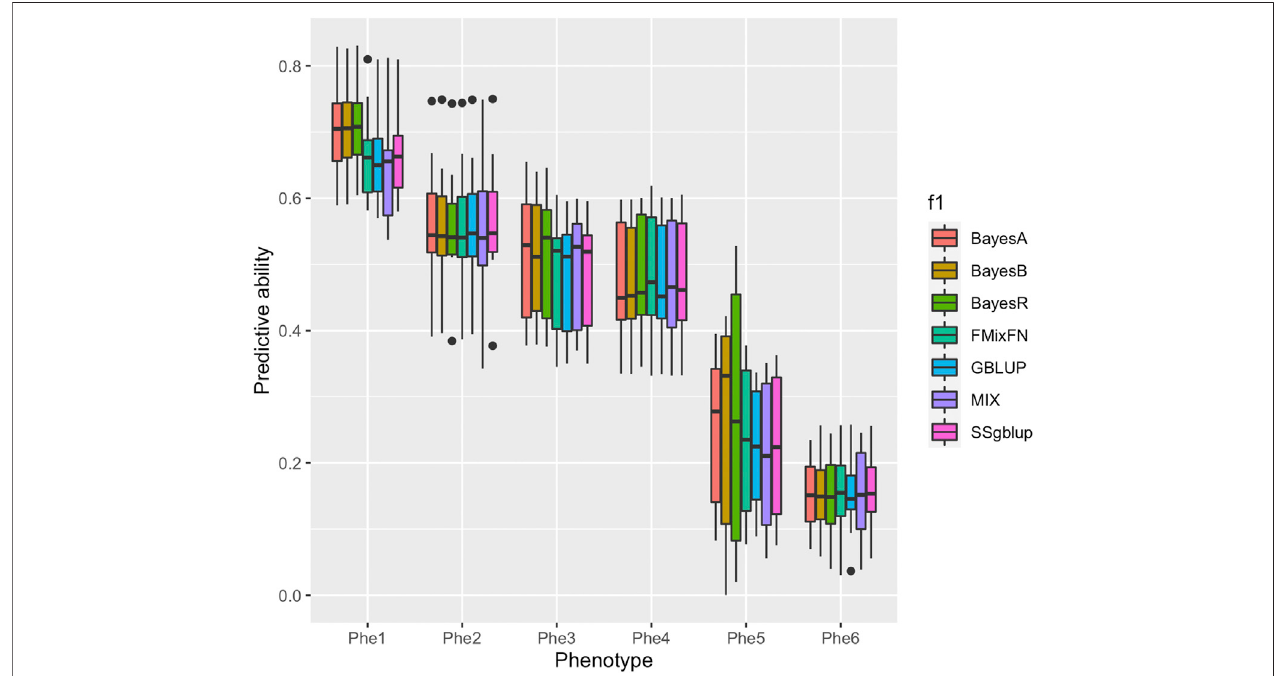
FIGURE 1 | Comparison of predictive ability of BayesA, BayesB, BayesR, FMixFN, GBLUP, MIX, and SSgblup in all six traits. The predictive ability performance of each method was measured by the correlation method, which is the average Pearson correlation between predicted values and phenotypic values.